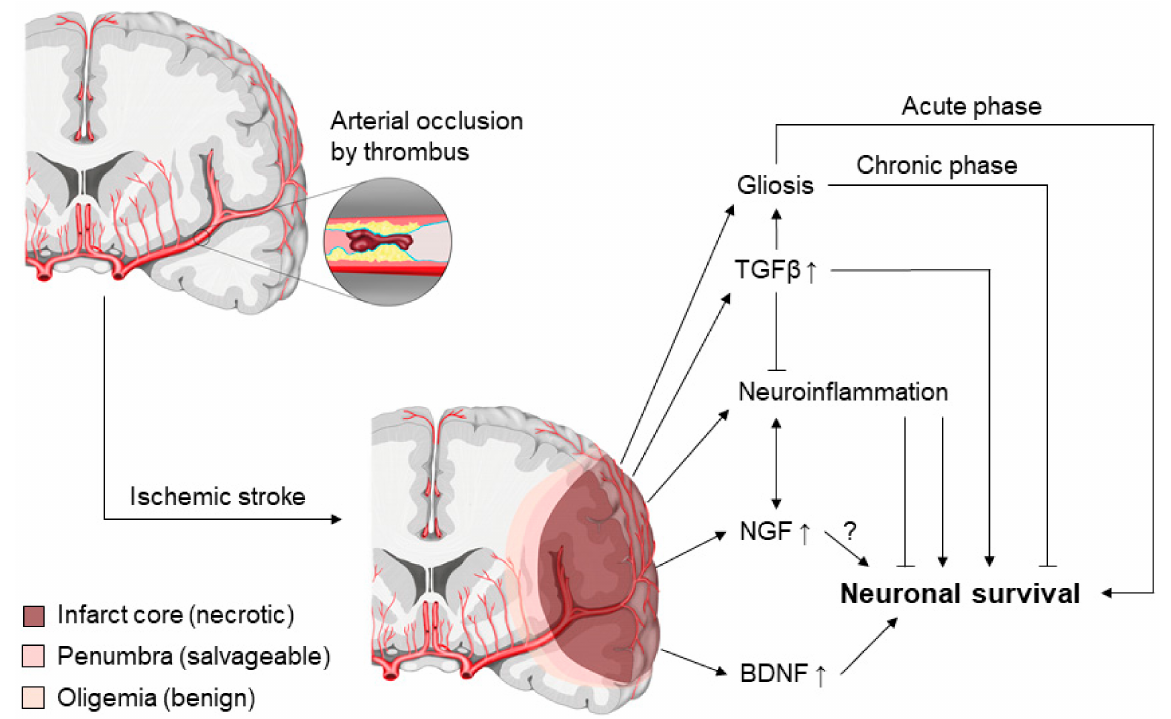
Figure 5. Roles of TGF β and neurotrophins in recovery from ischemic stroke. Ischemic stroke is induced by a thrombus occluding a brain artery, which impairs blood supply distal to the occlusion. Neurons within the infarct core (<12 mL blood/100 g tissue/min) die rapidly and become necrotic. Neurons within the penumbra (12–22 mL blood/100 g tissue/min) can recover depending on timely reperfusion and the action of different neuroprotective factors such as TGF β and neurotrophins. Neurons within the oligemia (22–35 mL blood/100 g tissue/min) usually recover completely from the mild ischemia, irrespective of treatment. Gliosis and neuroinflammation are a response to the tissue damage and regulated by TGF β and neurotrophins. They can be both beneficial and detrimental to post-stroke recovery and neuronal survival. TGF β = transforming growth factor β , NGF = nerve growth factor; BDNF = brain-derived neurotrophic